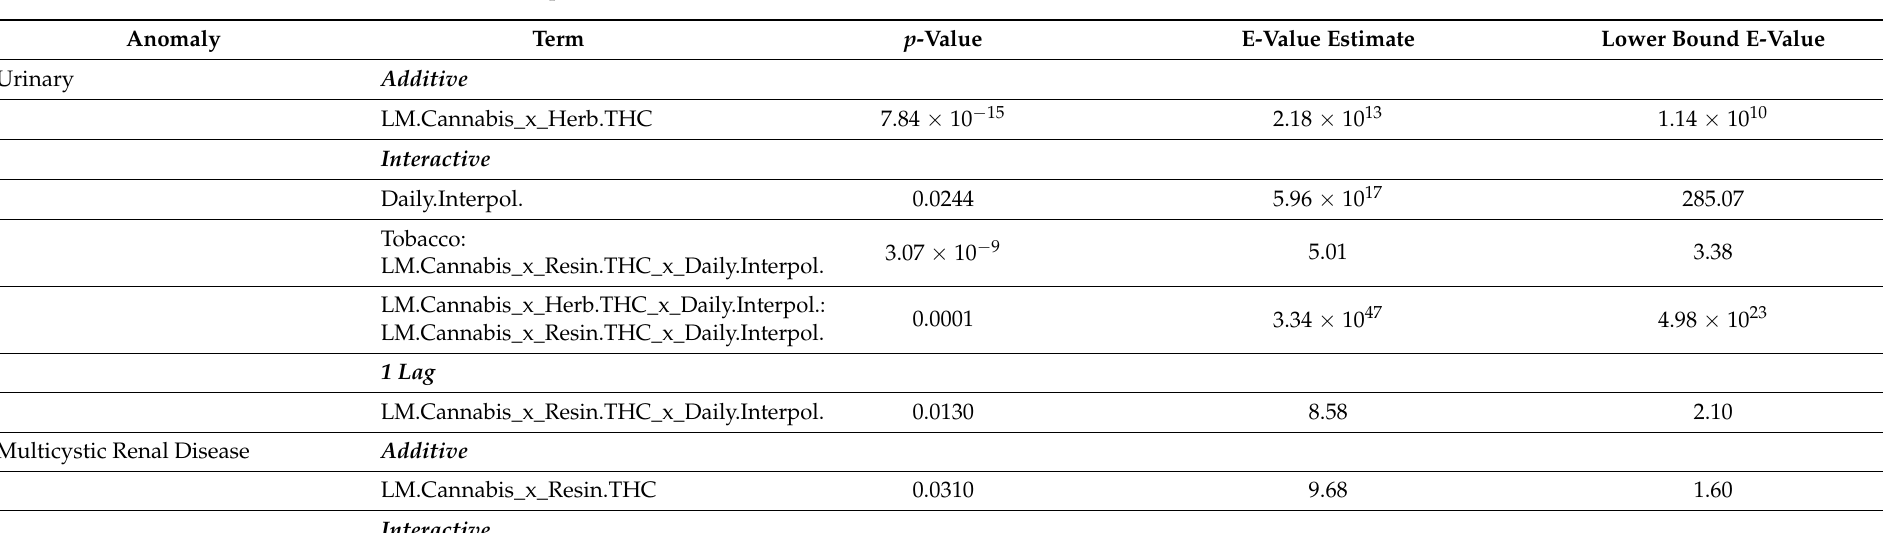
Table 8. E-Values from Spatial